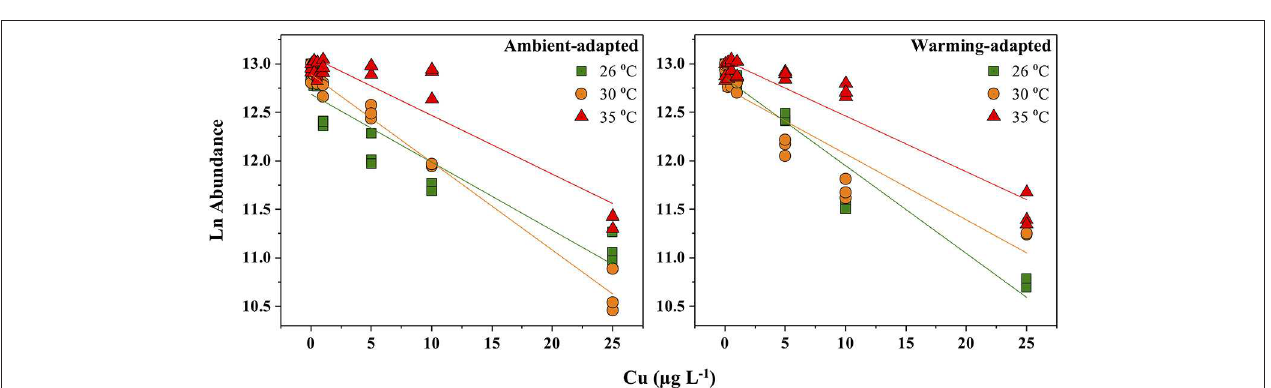
Frontiers in Environmental Science |